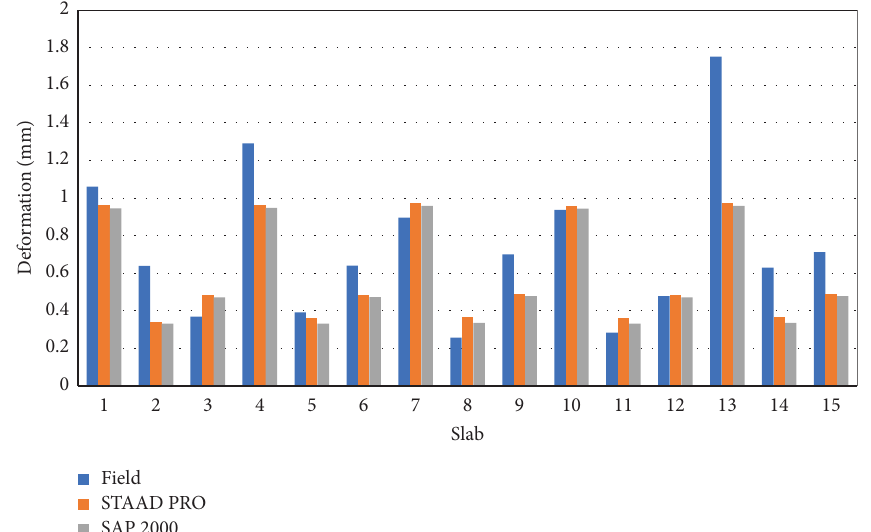
Figure 12: Maximum deformations in